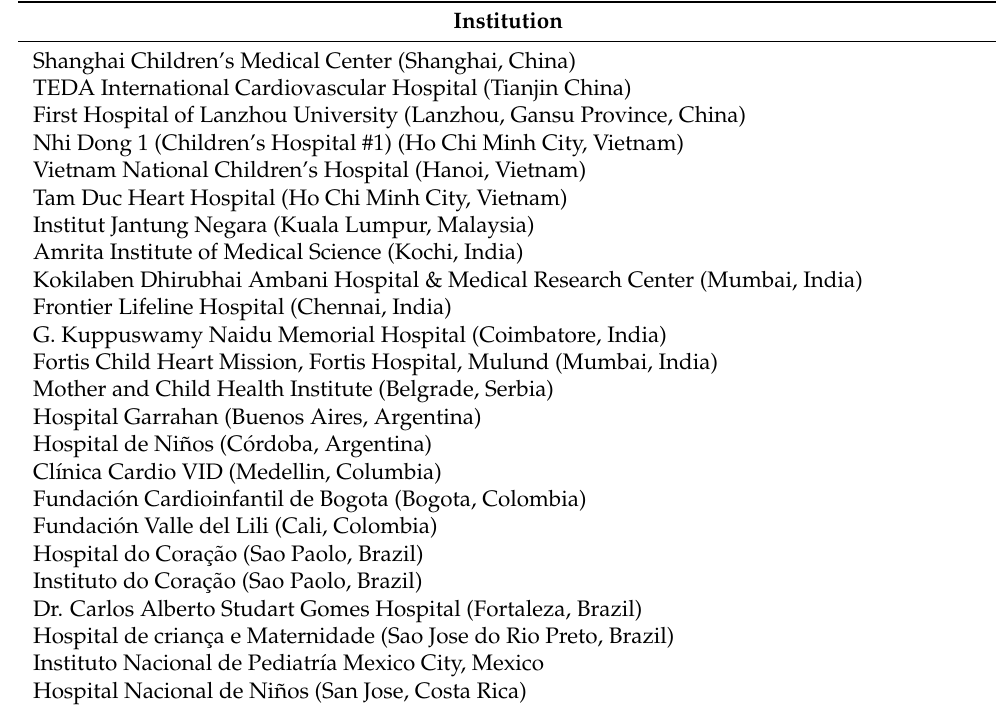
Table 1. List of institutions who reported cases of PVS that were